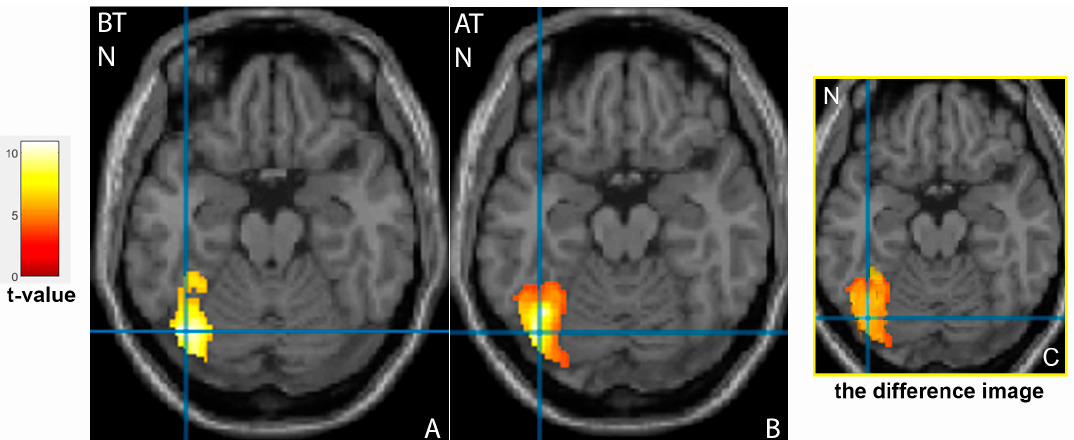
Figure 3. Activation of the left fusiform gyrus ( A , B ) in patients before (BT) and after (AT) antide ‐ pressant therapy on demonstration of neutral faces (N). The corresponding difference image ( C ) showed a significant decrease of activation area in the left fusiform gyrus, BA37 for neutral faces ( p < 0.001).